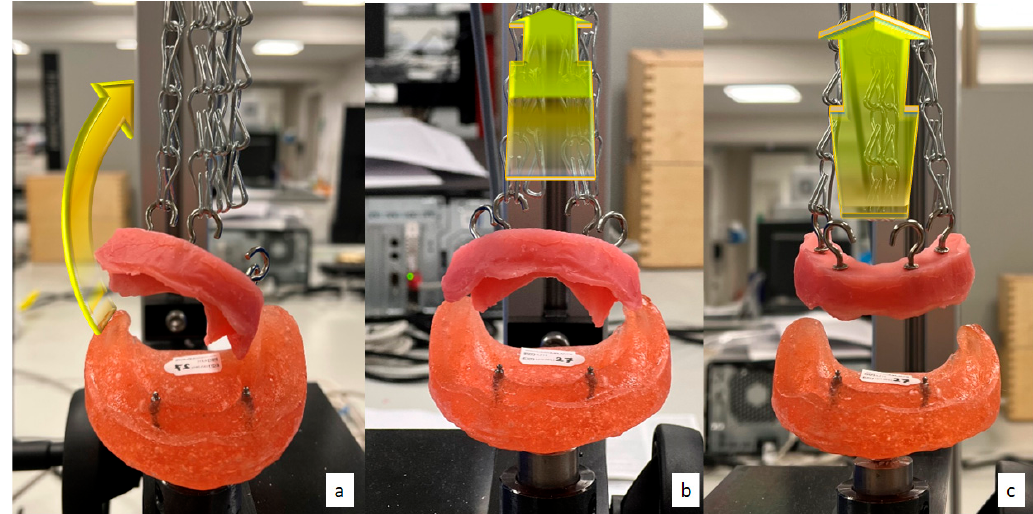
Figure 2. Three oblique dislodgments: ( a ) right lateral, ( b ) anterior and ( c ) posterior directions.